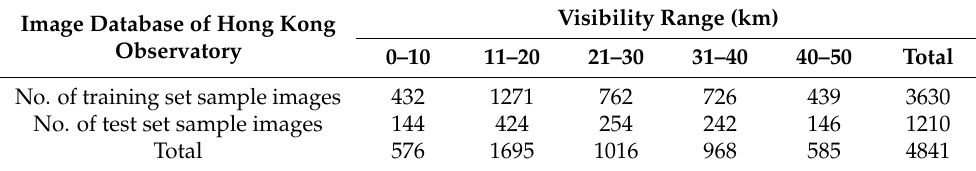
Table 3. Visibilities distribution of the image